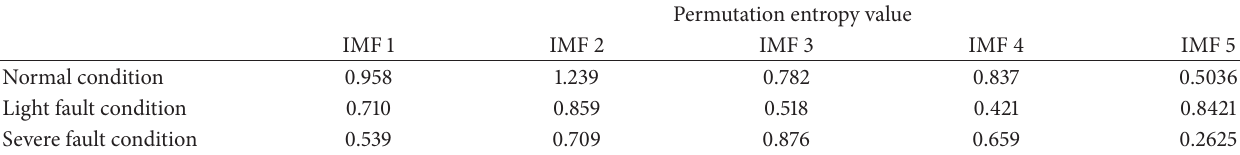
Table 2: Permutation entropy values of IMF 1 ∼ IMF 5.